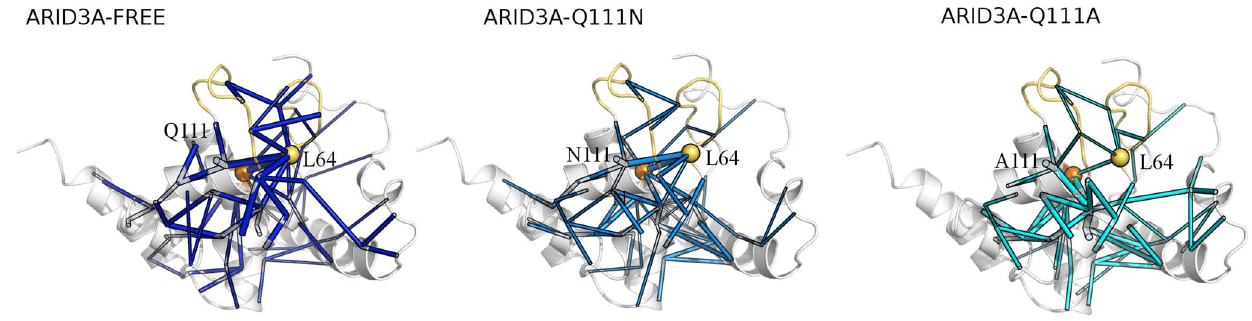
Figure 9. Paths of long-range communication mediated by Q111 in wt, Q111A and Q111N ARID3A. The shortest paths of communications mediated by Q111 in ARID3A FREE , (left panel) ARID3A Q111A (middle panel) and ARID3A Q111N (right panel) simulations as identified by the PSN-LMI approach are shown as cylinders of thickness proportional to the probability of occurrence. The Q111 C a and the L64 C a are also indicated by orange and yellow spheres, respectively. L1 and L2 are highlighted in